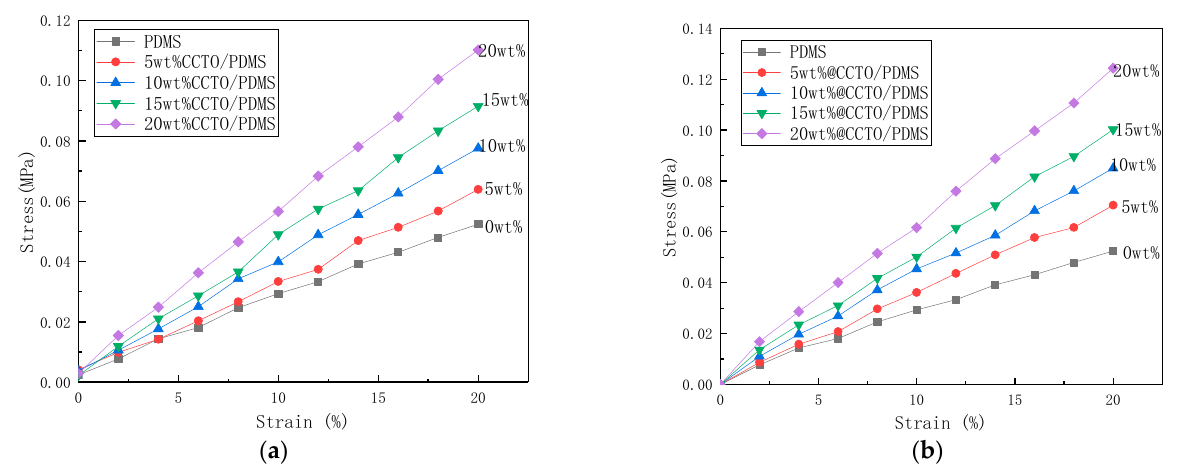
Figure 10. (a) The stress-strain curve of CCTO/PDMS composite; (b) The stress-strain curve of Figure 10. ( a ) The stress-strain curve of CCTO/PDMS composite; ( b ) The stress-strain curve of modified modified CCTO/PDMS(@CCTO/PDMS) composite. CCTO/PDMS(@CCTO/PDMS) composite.